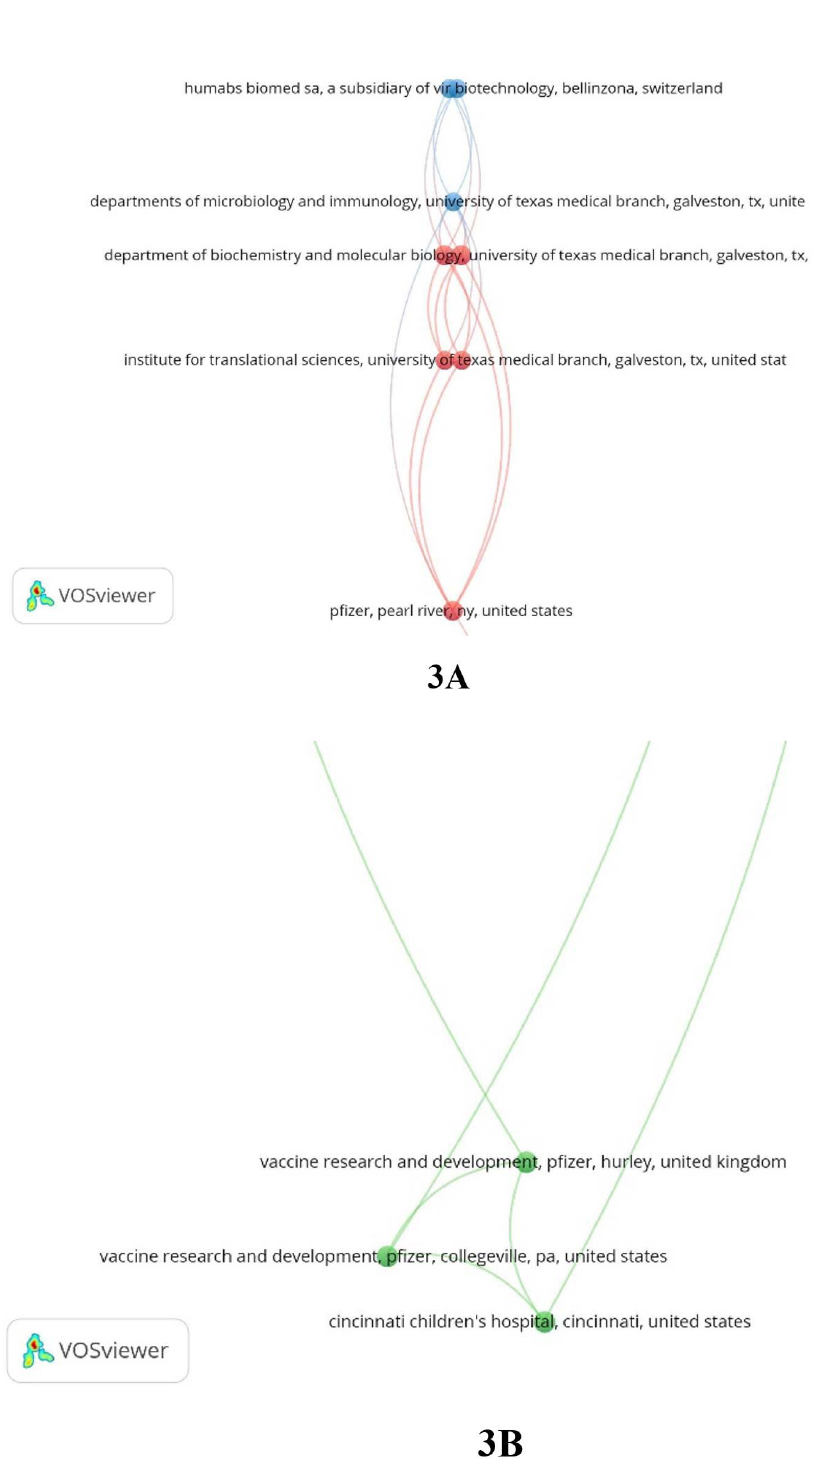
Fig. 3A,B. The co-authorship network for